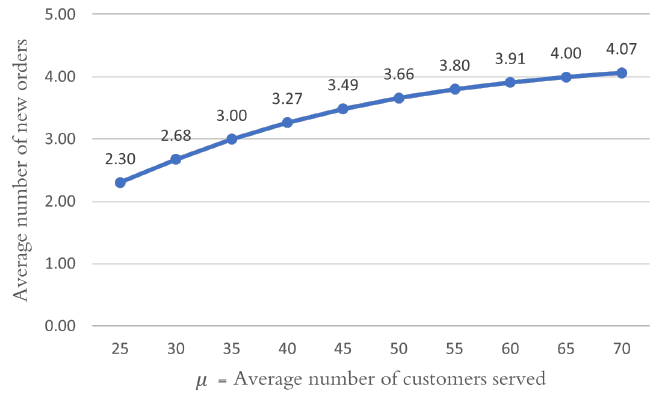
Figure 4. Effect of changing the speed of service with respect to the number of new orders under a deterministic order